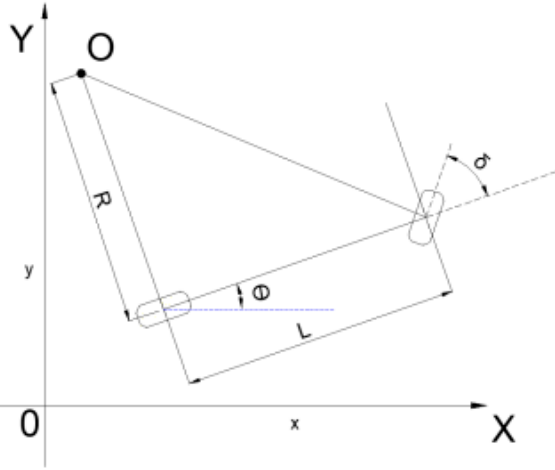
Figure 3. Bicycle model adapted to paddy field management machine.